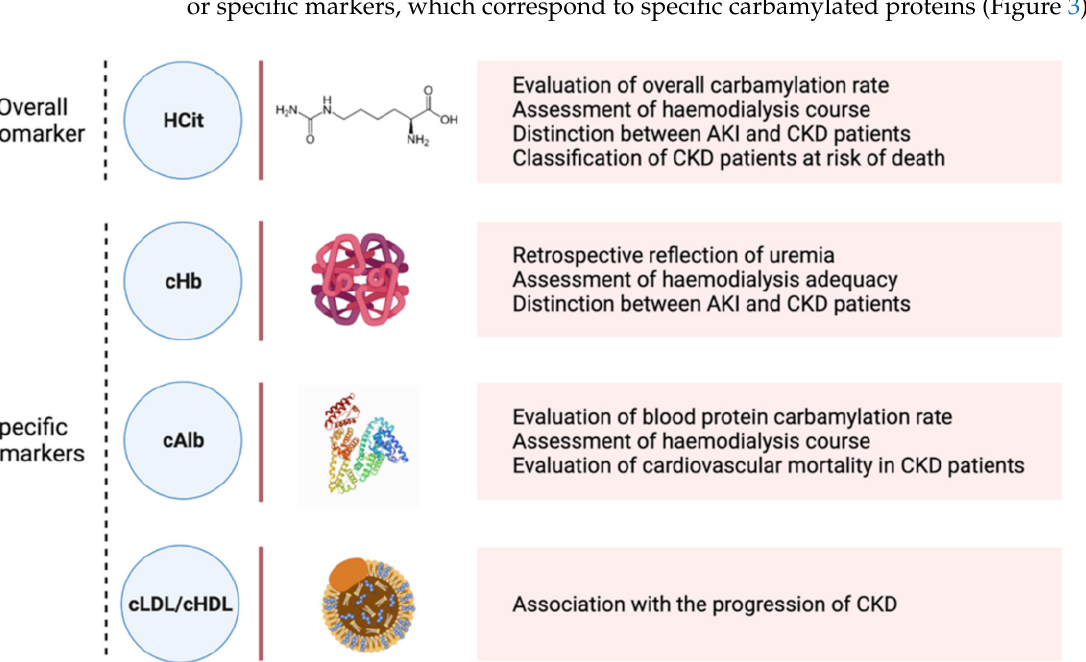
Figure 3. CDPs identified as biomarkers of carbamylation. HCit: homocitrulline; cHb: carbamylated haemoglobin; cAlb: carbamylated albumin; cLDL: carbamylated low-density lipoprotein; cHDL: carbamylated high-density